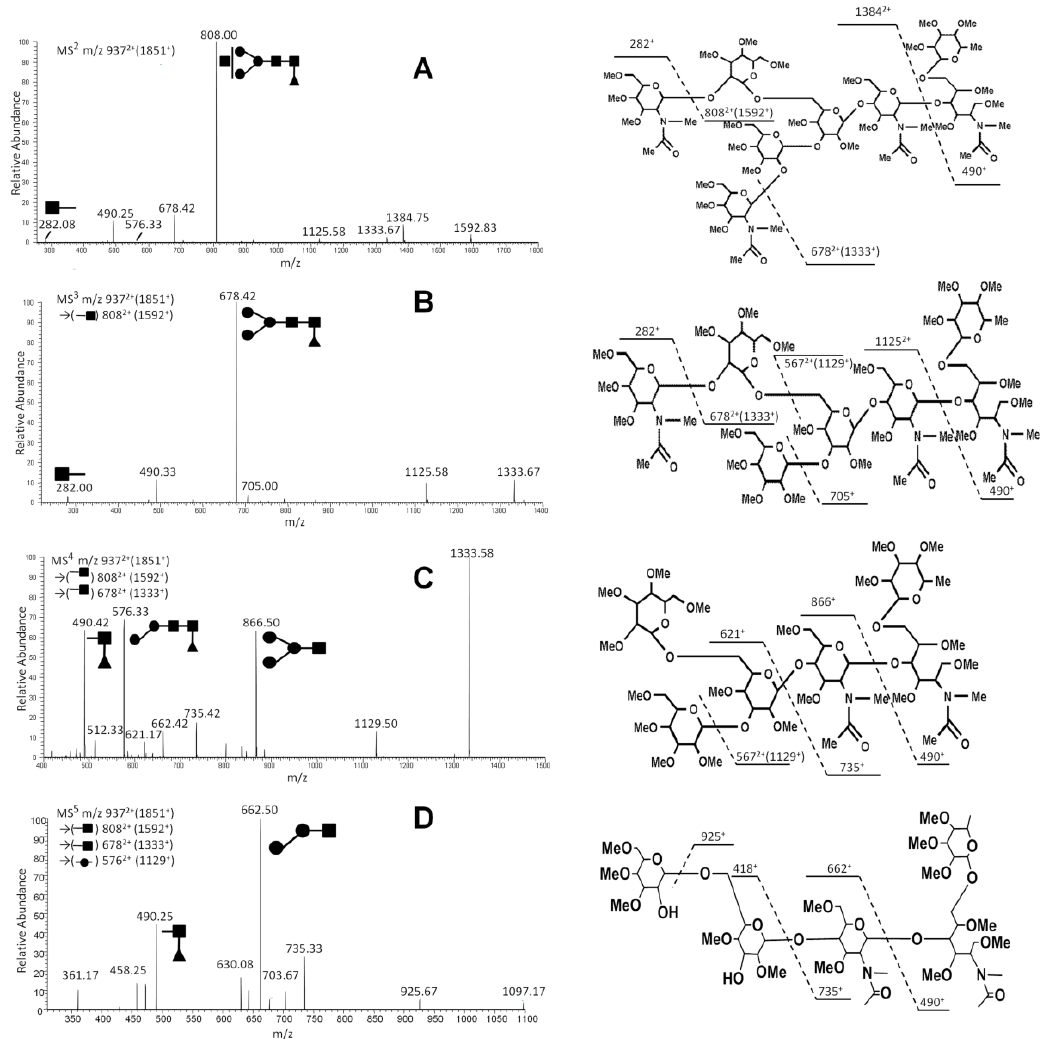
Figure 3. Multistage MS (MS n ) pathway of the doubly changed ion at m / z 937 in serum from a rheumatoid arthritis patient. The pathway consists of MS 2 m / z 937 2 + ( A ), MS 3 m / z 808 2 + ( B ), MS 4 m / z 678 2 + ( C ) and MS 5 m / z 567 2 + ( D ), along with their respective chemical structures. Table 2. Major ion fragments in MS n .